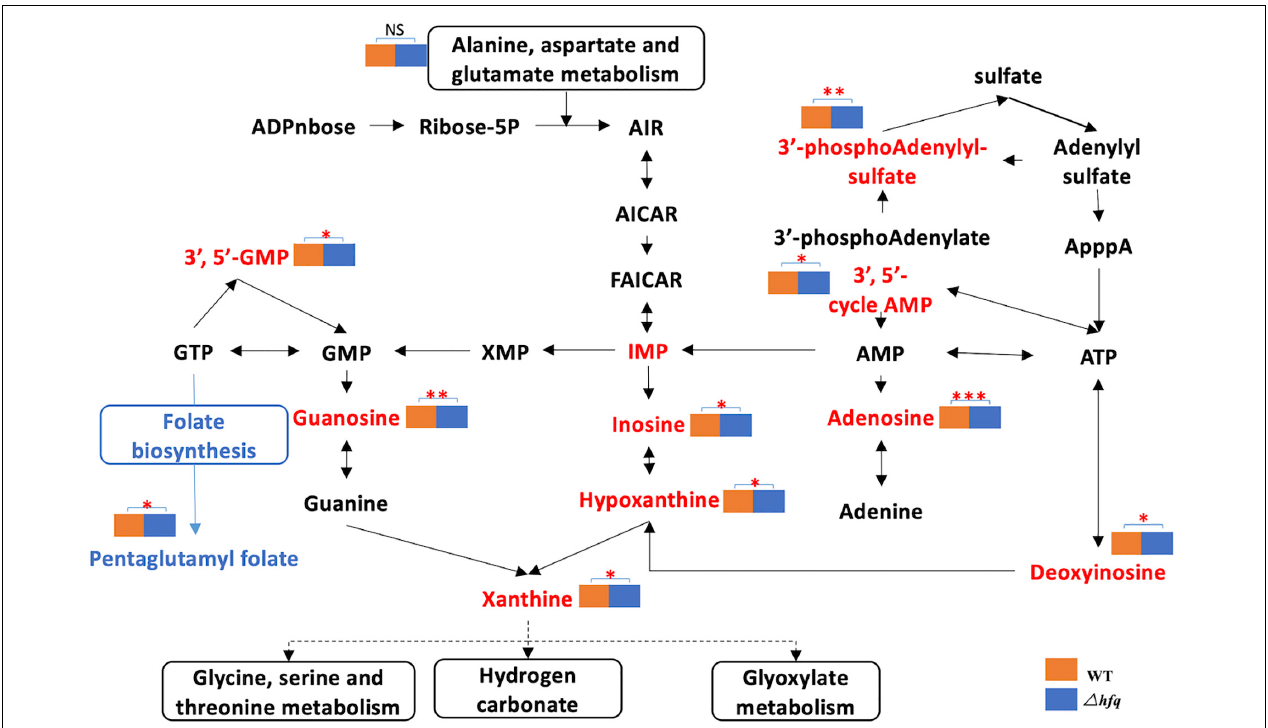
FIGURE 5 | Metabolites of the purine metabolic pathway of Aeromonas veronii . The red font indicates the increased metabolites, and the blue color indicates the decreased metabolites. The metabolic pathway is framed by a solid line. ∗ represents the difference between (cid:49) hfq and wild-type metabolites. ∗ represents p < 0.05, ∗∗ represents p < 0.005, and ∗∗∗ represents p <